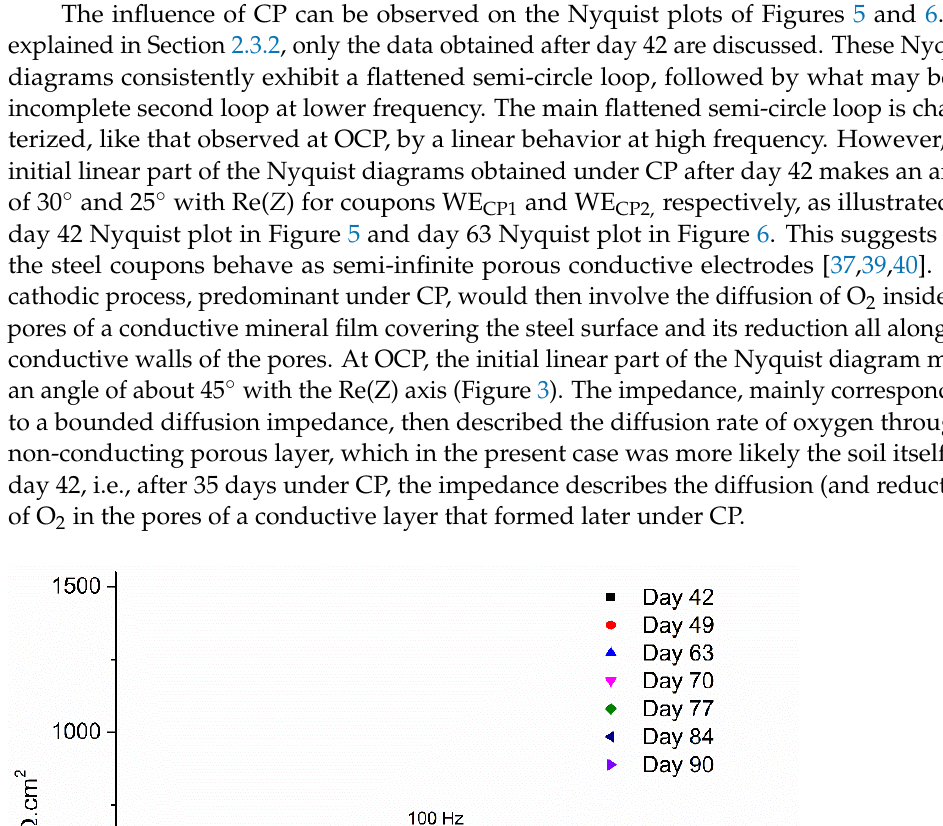
Figure 6. Evolution of the EIS Nyquist plots with exposure time for coupon WE CP2 ( E CP = − 1.2 V vs. Cu/CuSO 4 ) between days 42 and 90. To obtain additional information and quantify the evolution of the steel/soil interface with time, a modelling of the EIS data obtained for the coupons under CP was achieved. The EEC used for both coupons is displayed in Figure 4b. In this EEC, Q 1 and R 1 are a CPE and a resistance, respectively, used to model the phenomenon associated with the main flattened capacitive loop present in all cases (Figures 5 and 6). Q 2 and R 2 are the elements used to fit the low frequency part of the impedance diagram. Because only a very small part of the corresponding capacitive loop (if one assumes this is really a capacitive loop) is seen, various values could be obtained for Q 2 and R 2 parameters and consequently these